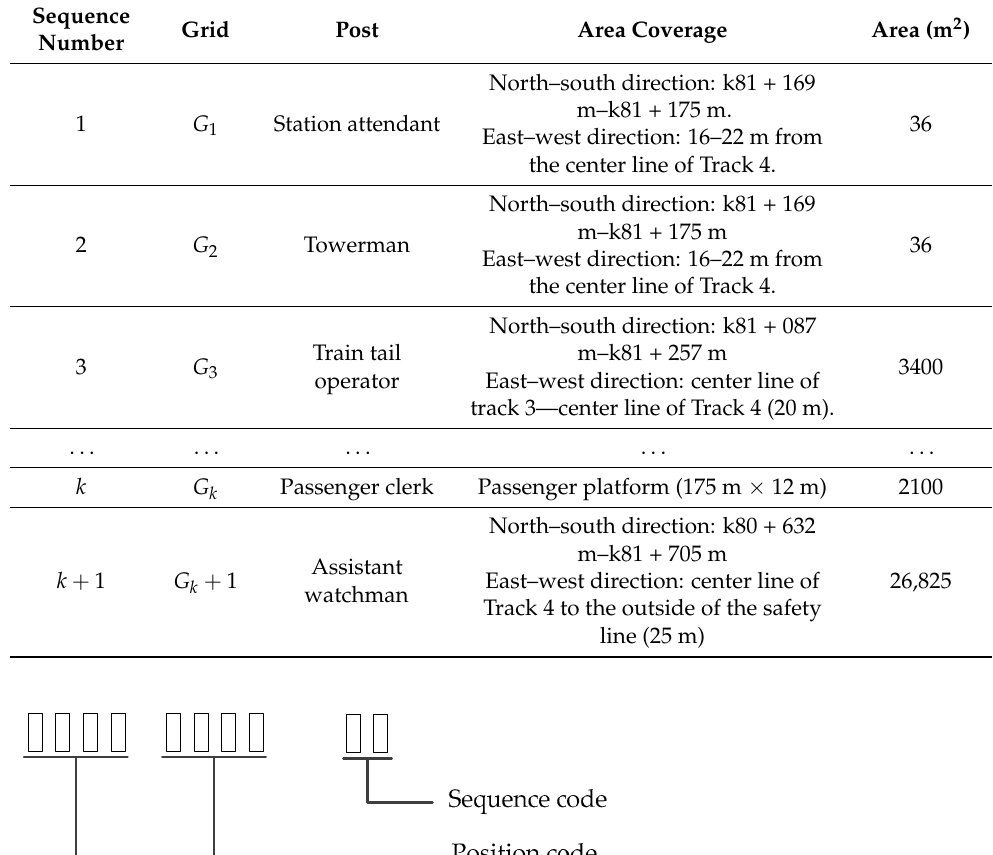
Table 1. Grid attribute data of the train operation department.